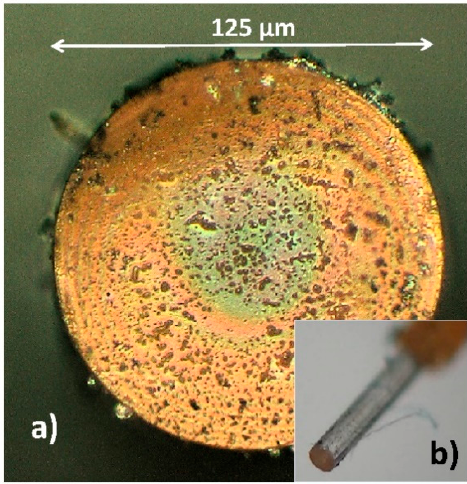
Figure 4. Micrograph of the Nafion ® -based FP humidity sensor probe ( a ) end surface of FP fiber optic covered Nafion ® film, ( b ) fiber tip sensor.